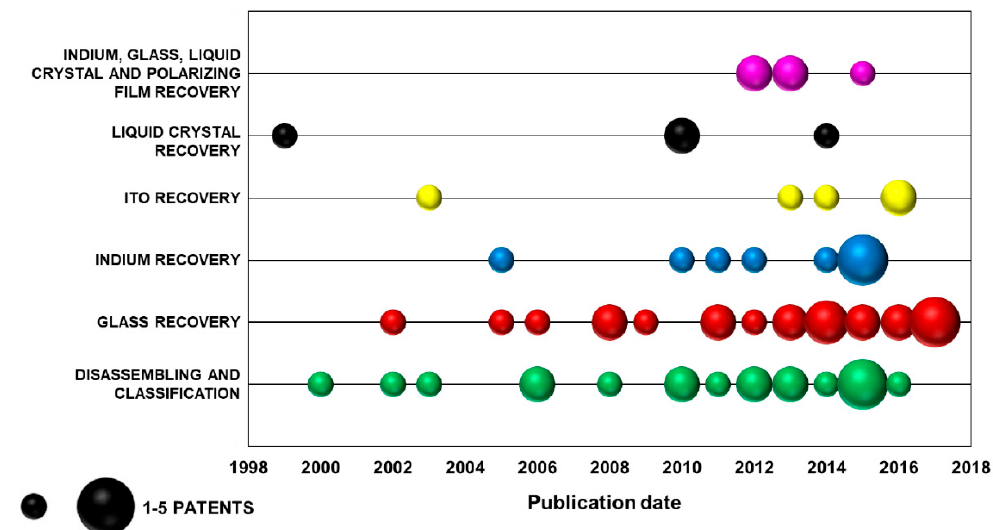
Figure 1. Technological evolution of end-of-life liquid crystal display (LCD) recycling treatments. ITO, indium and tin oxide.